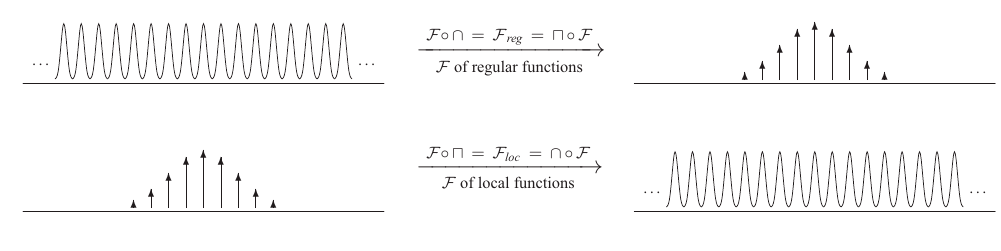
Figure 3. The regularization–localization theorem. Figure 3. The Regularization-Localization Theorem.